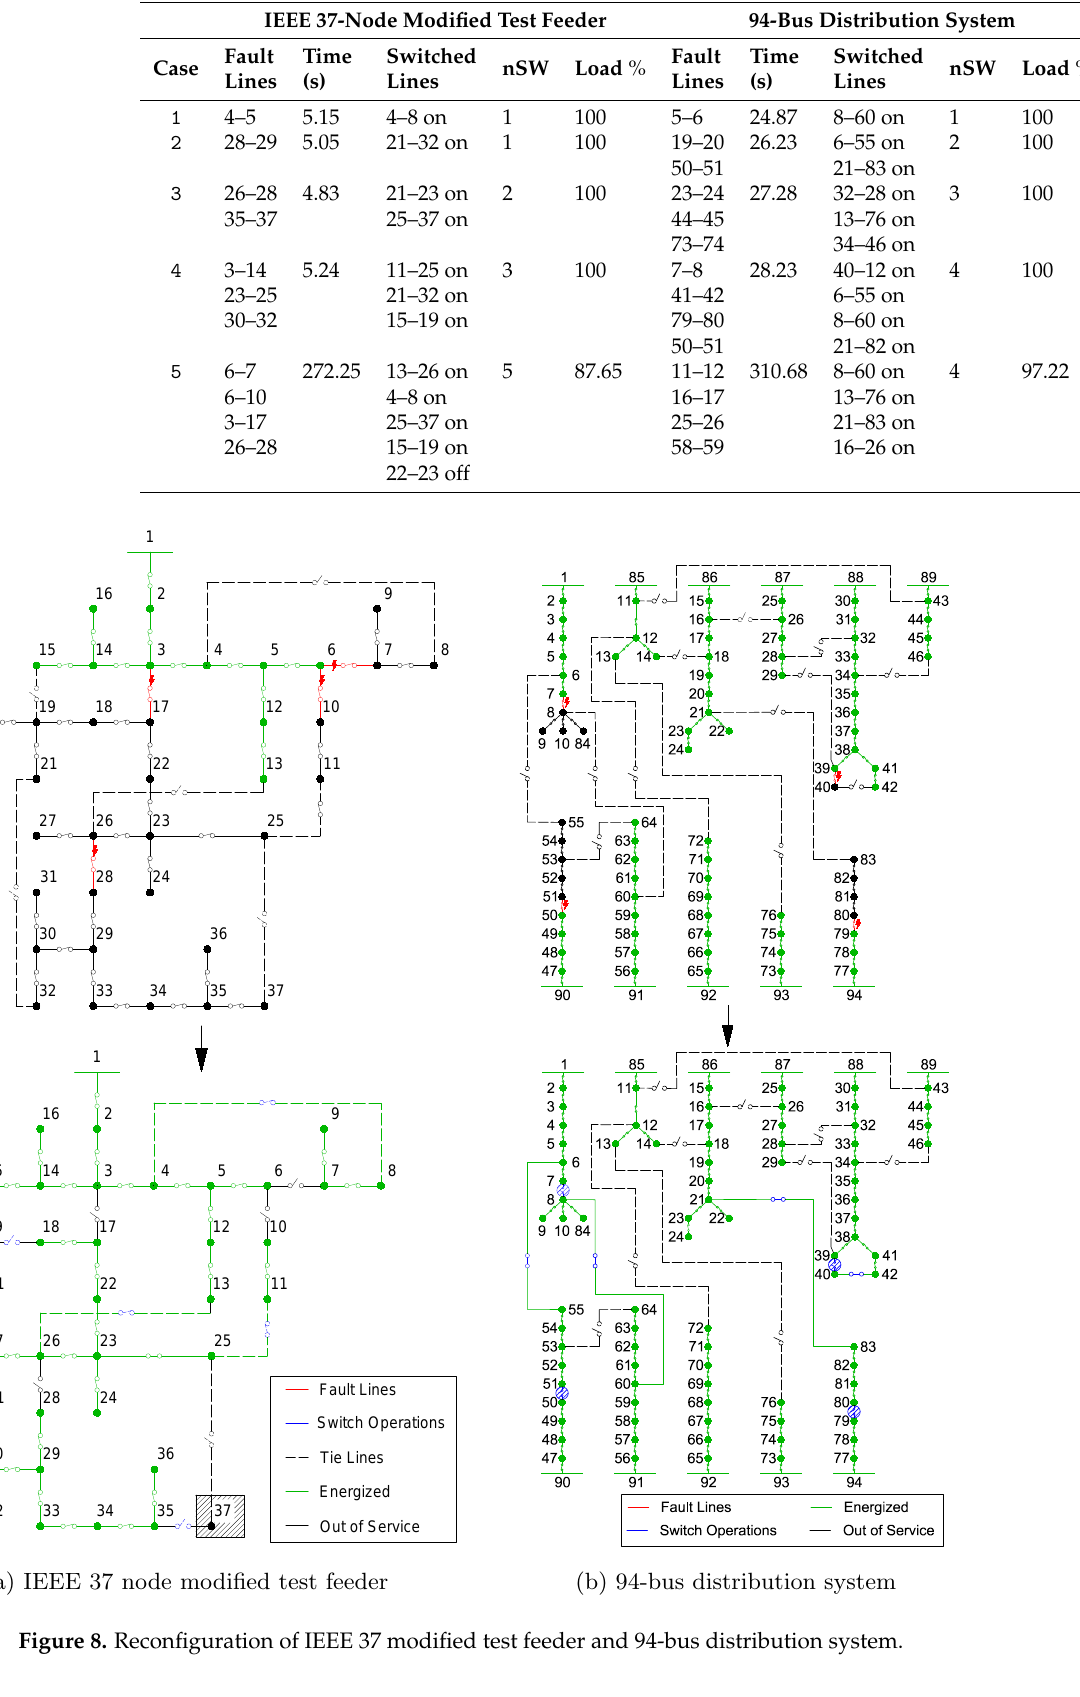
Table 2. Simulation results of IEEE 37-node modified test feeder and 94-bus distribution system.